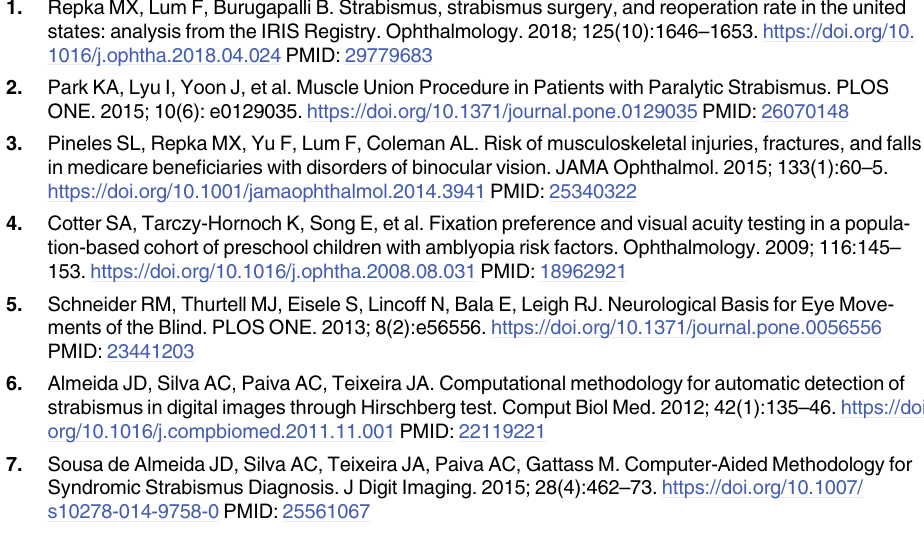
S1 Fig. Eye region images for evaluating the proposed